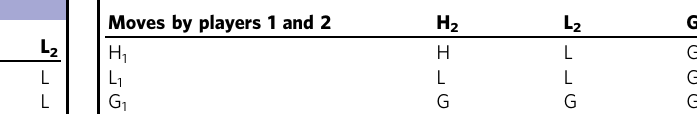
Table 1 Climate policy resulting from each pair of moves. High mitigation agreement (H) is only possible if both players choose H over low (L) mitigation.